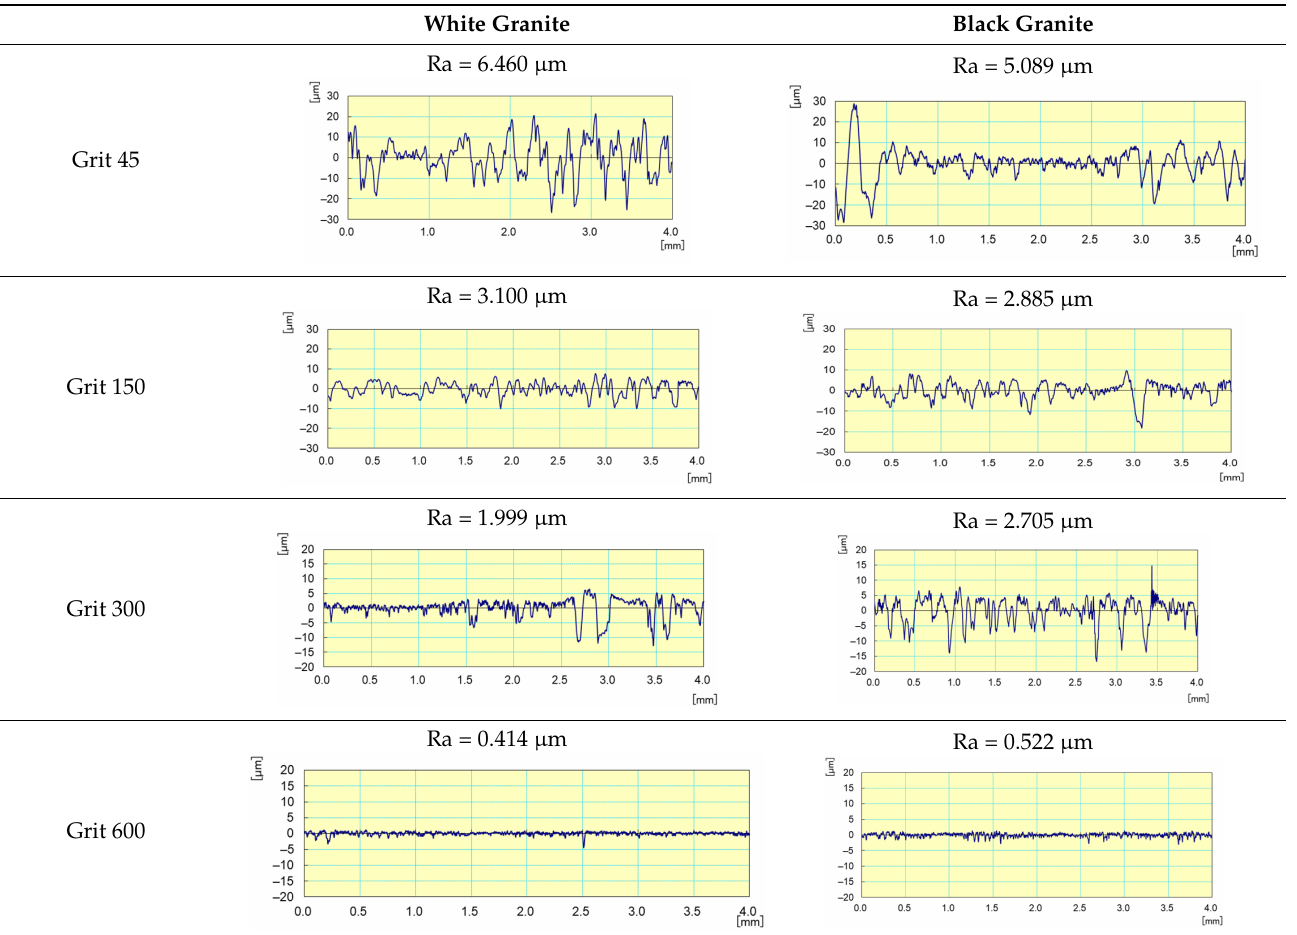
Figure 23. Surface finish results on white and black granite samples after wet edge finishing. Table 3. Evolution of surface profiles and roughness Ra roughness of white and black granite as a function of grits (Vs = 2500 rpm; f = 1000